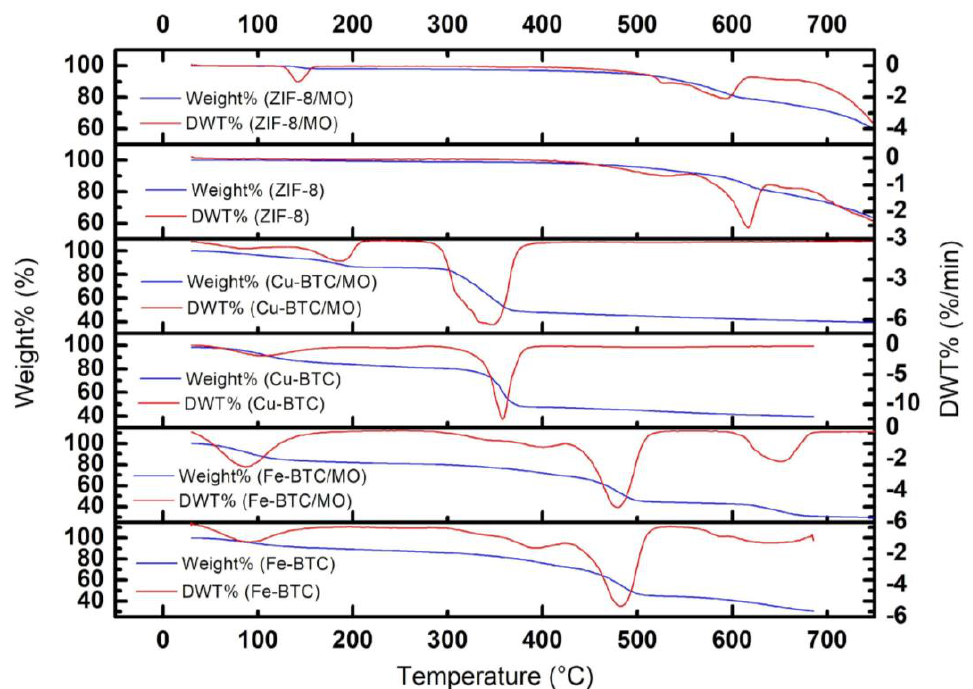
Figure 5. TGA profiles of the MOFs before and after MO